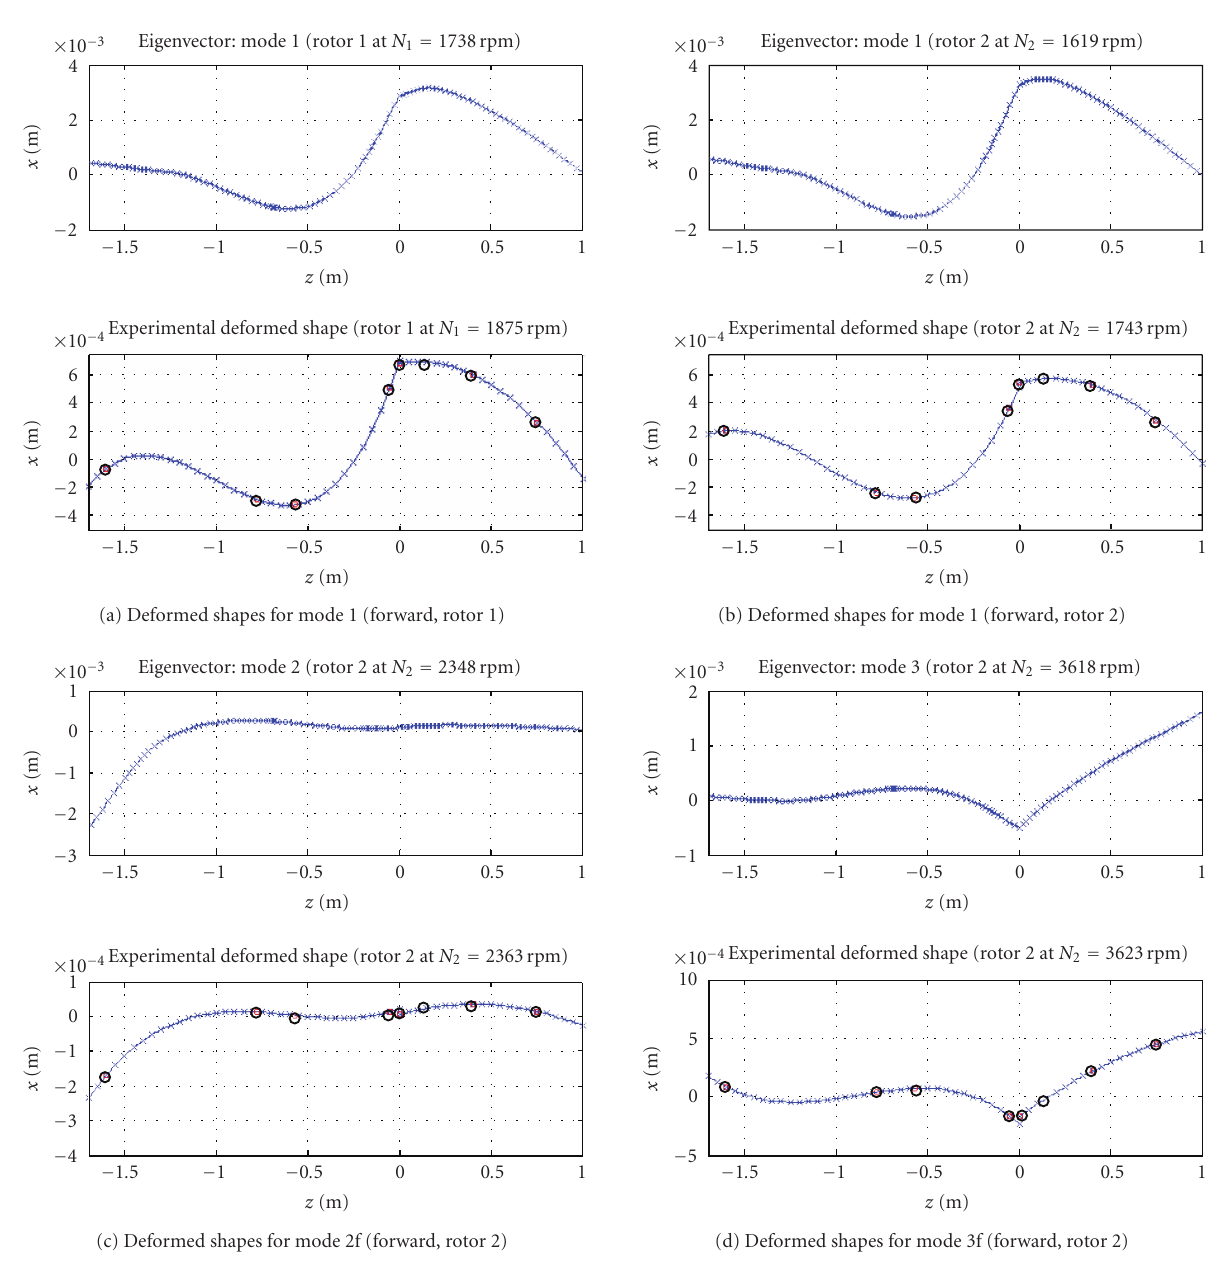
(c) Deformed shapes for mode 2f (forward, rotor 2) Figure 8: Deformed shapes: predicted (upper) and observed (lower). Bold dots denote measurement